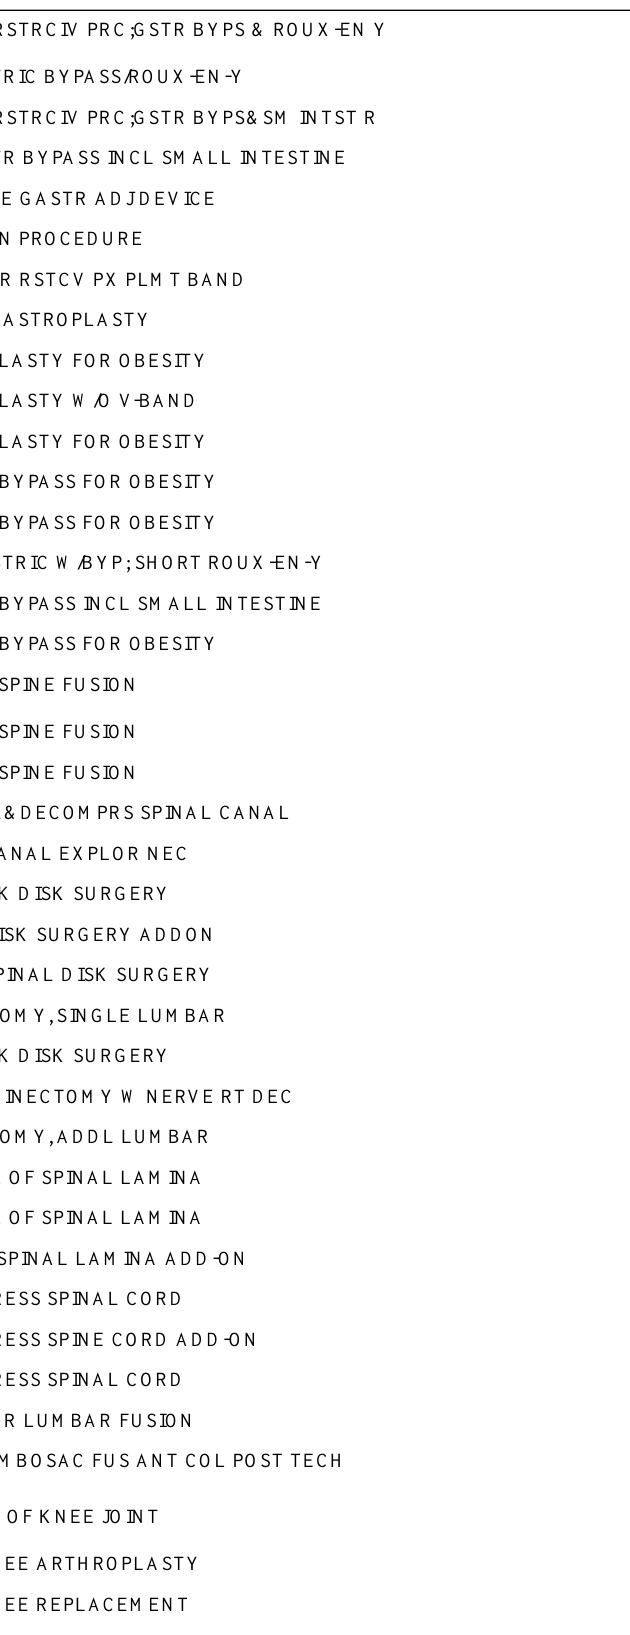
Table 1. Procedure codes and selection criteria for bariatric surgery, lumbar surgery, and total knee replacement.